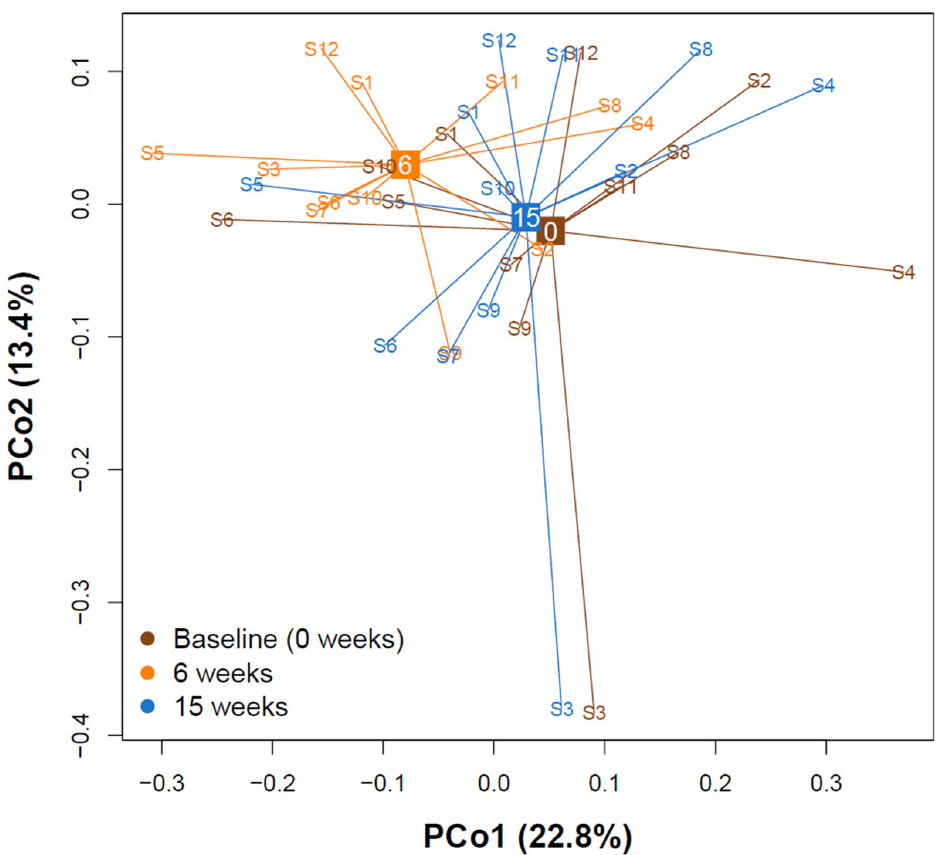
Fig 3. Principal coordinate analysis (PCoA) of Bray-Curtis dissimilarity. PCoA of 36 gut microbiota samples belonging to twelve participants at three different time points (baseline/0 weeks, six weeks and fifteen weeks). The two major PCo1 and PCo2 are shown. All samples are connected to the centroid (displayed as square) of their respective time point. The microbial communities shifted markedly between baseline and six weeks, then returned towards baseline after fifteen